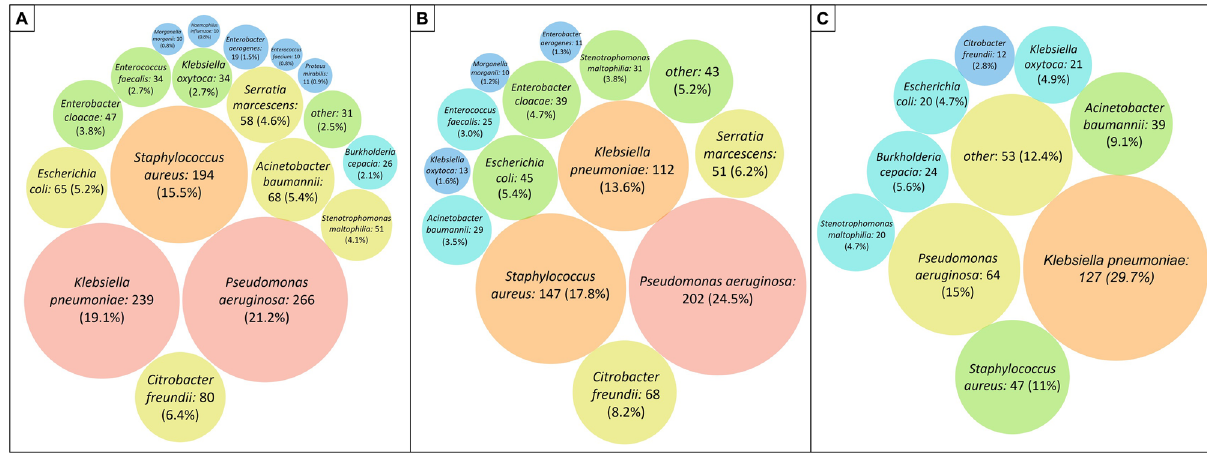
Figure 2. Aetiological pathogens. Here is presented the frequency (in counts) of the etiological isolations in the whole cohort of patients with VA-LRTI. ( A ) Shows microorganisms isolated in the general cohort. ( B ) Represents the VAP cohort and Panel C depicts the VAT cohort. Within the “Other” group are microorganisms with less than five isolates ( Achromobacter xylosoxidans , Acinetobacter lwoffii , Citrobacter koseri , Hafnia alvei , Moraxella catharralis , Neisseria cinerea , Providencia rettgeri , Raoultella planticola , Raoultella ornithinolytica , Streptococcus anginosus , and Streptococcus pyogenes ).